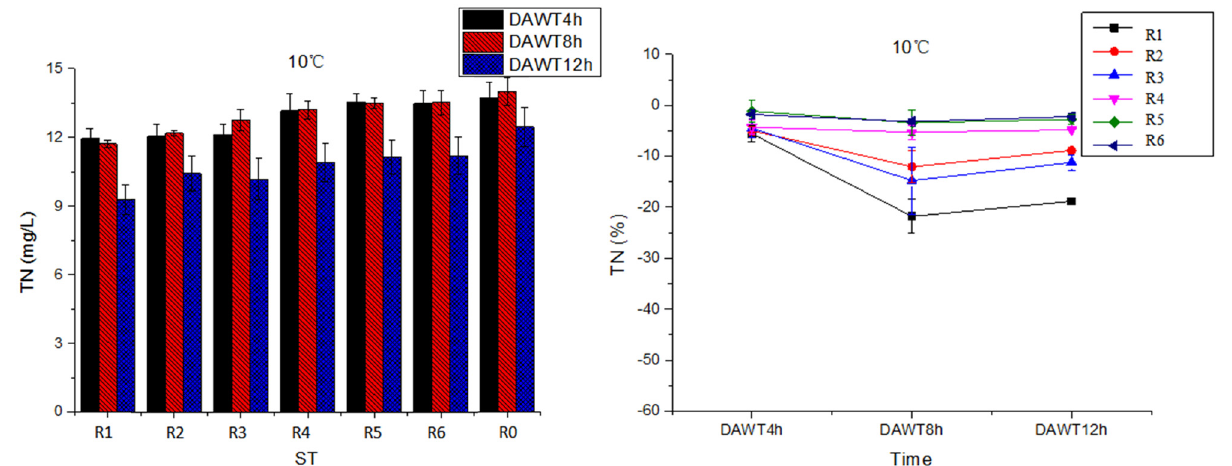
Figure 6: TN varies with